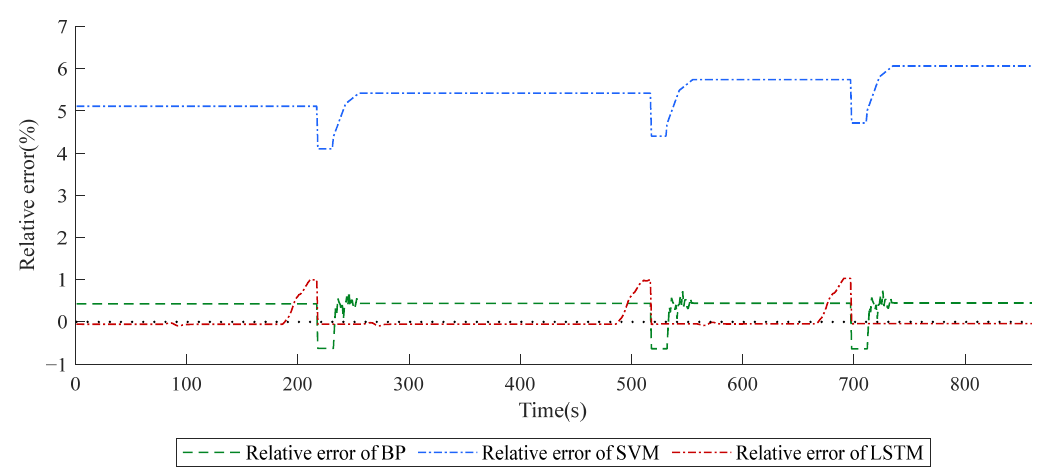
Figure 9. A comparison of the forecast values for the winter data.